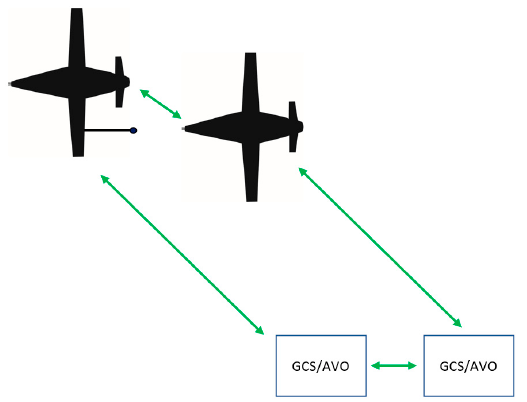
Figure 11. Visual depiction of data links required between multiple UAs and GCSs/AVOs. To transmit data and voice between multiple GCSs, if the GCSs are geographically located in a close area, a fiber optic cable or ethernet may be routed to pass information between GCSs [51]. Alternatively, mobile networks operating in ultra ‐ high ‐ frequency (UHF, 300 MHz to 3 GHz), low ‐ frequency (L, 30 to 300 kHz ) , or S Band (2 to 4 GHz) fre ‐ quency bands using Commercial Off The Shelf (COTS) components [54] or wireless sensor networks (WSN) in the C frequency Band (4 to 8 GHz, reserved for satellite communica ‐ tions) [55] could be leveraged to pass data and voices between GCSs. If the range between GCSs does not allow for a fiber, ethernet, mobile network, or WSN, either a Line ‐ Of ‐ Sight (LOS) or Beyond LOS (BLOS) solution would be